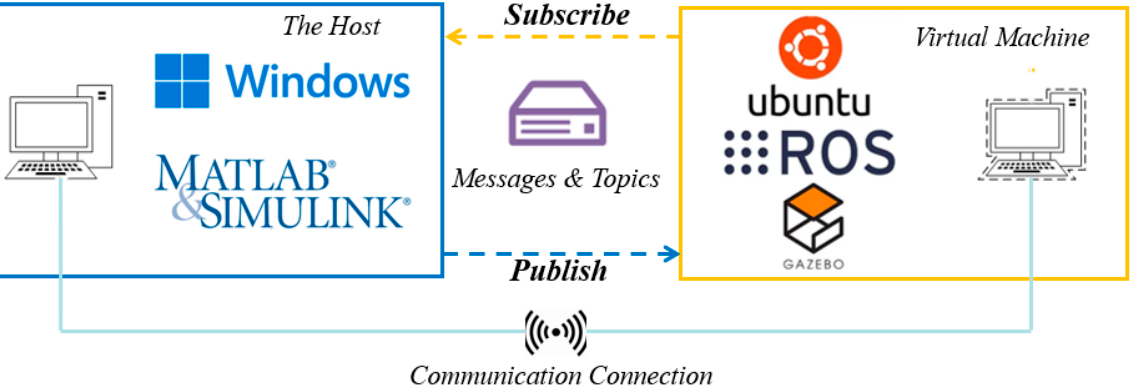
Figure 6. The schematic diagram of co-simulation based on Matlab and ROS.